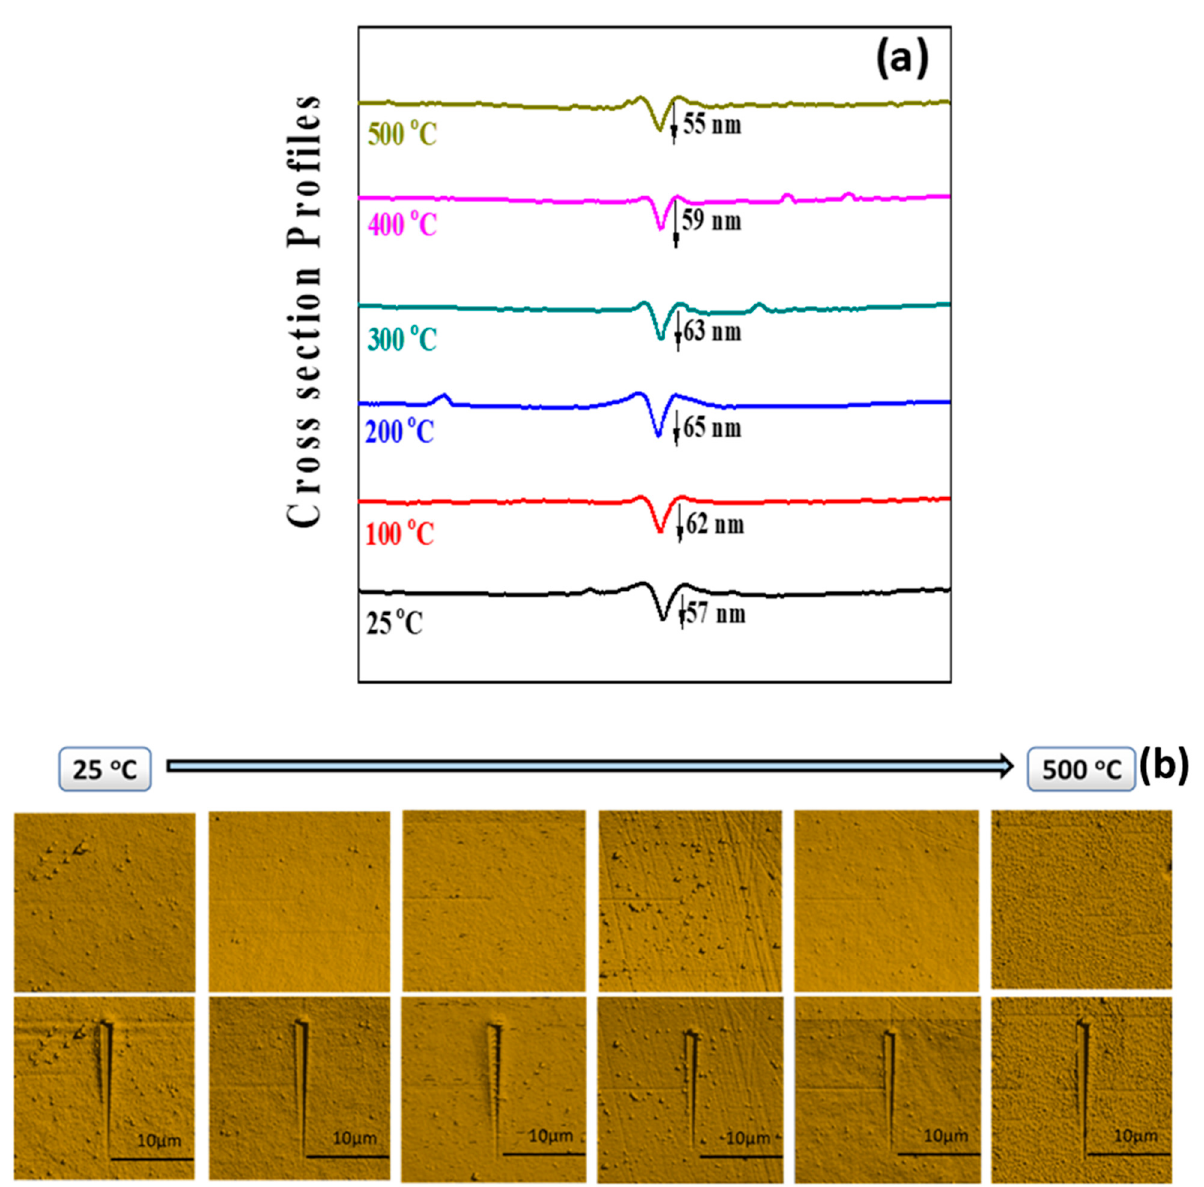
Figure 11. Nanoscratch test results of Mo films. The data shown are—( a ) cross-section profiles under scratch testing; ( b ) scratch testing images of Mo films.